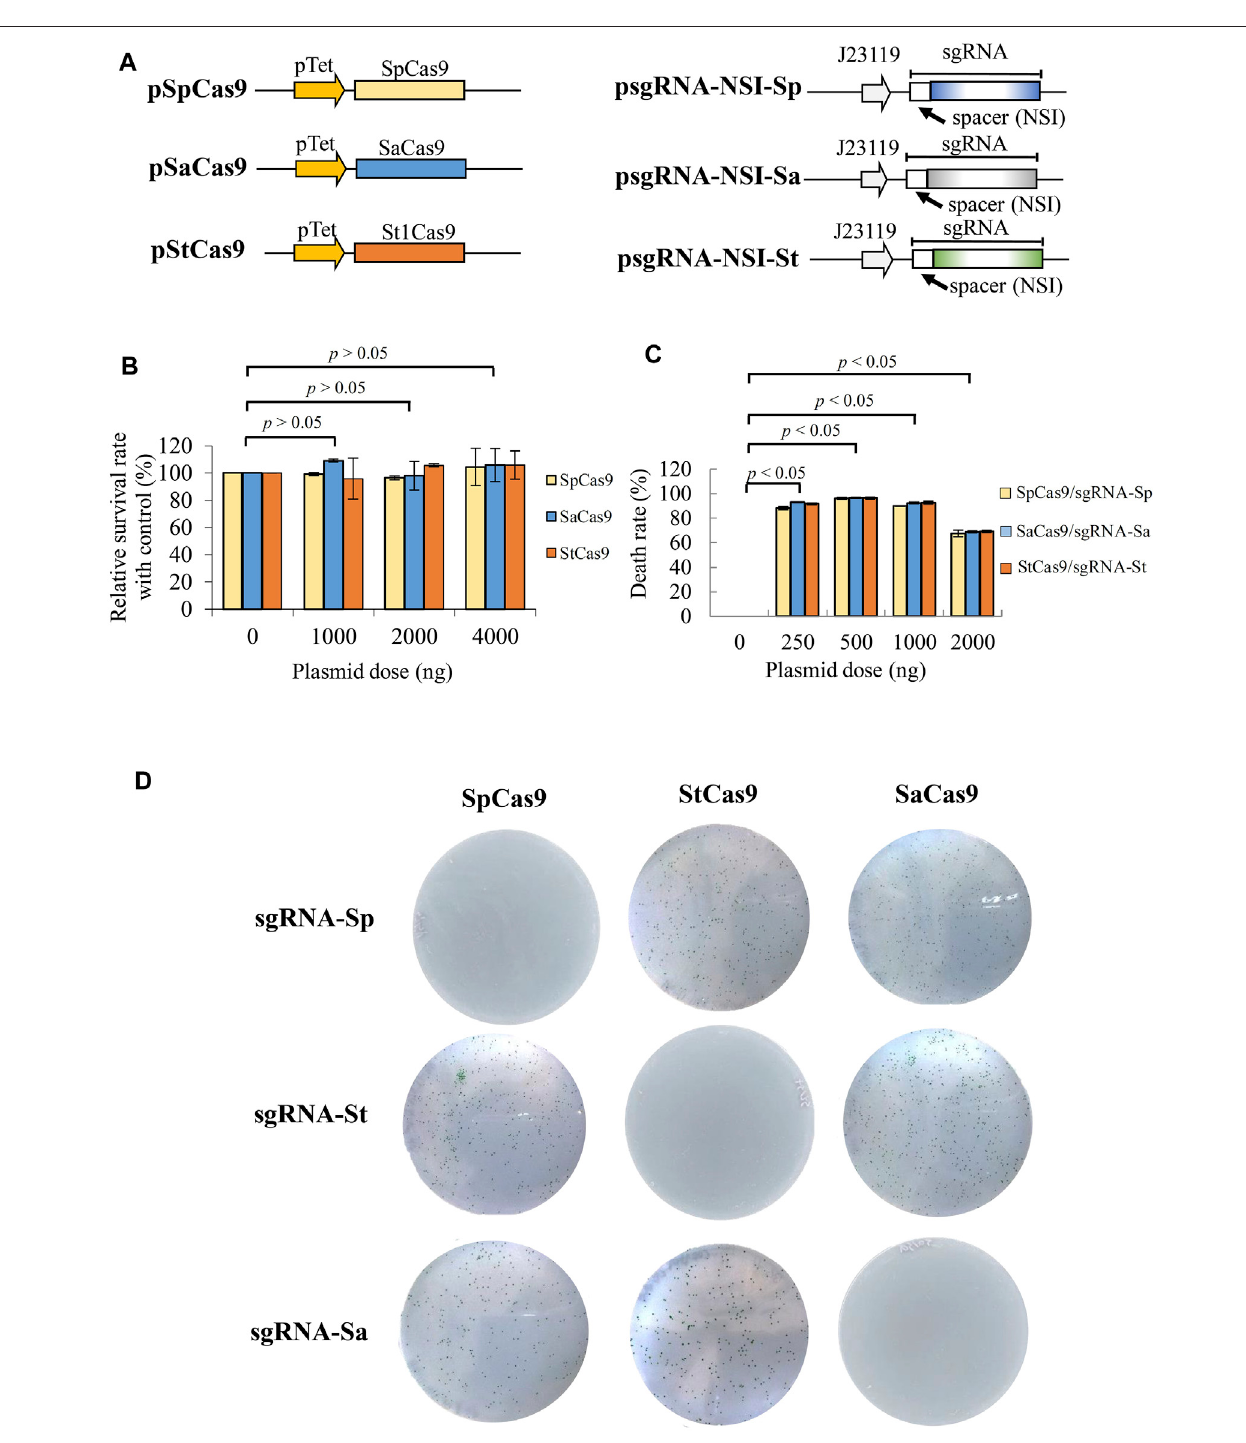
FIGURE 1 | Validation of orthogonal CRISPR systems for gene editing in PCC7942. (A) Plasmids encoding SpCas9, SaCas9, and St1Cas9 as well as plasmids encoding their corresponding sgRNA. Each sgRNA comprised identical spacer targeting NSI site but different scaffold backbone. sgRNA was driven by J23119 promoter. (B) Survival rate relative to the control. Cas9-expressing plasmid was transformed alone at different doses (1,000 – 4,000 ng). Nontransformed cells (0 ng) served as the control. Survivalrate was assessed by (CFU/CFUcontrol) × 100%. (C) Death rate induced by different cognate Cas9/sgRNApairs. Cas9-expressing plasmid was co-transformed with the corresponding sgRNA-expressing plasmid at different doses, and the death rate was assessed using nontransformed cells (0 ng) asthecontrol.Thedeathratewascalculatedby(1-CFU/CFUcontrol)×100%. (D) OrthogonalitytestforthreeCas9variants.TheCas9-andsgRNA-expressingplasmids were co-transformed into PCC7942 and streaked to plates. The plates were observed at day 7 – 9. The data represent the mean ± SD of three independent culture experiments and were analyzed by one-way ANOVA. p < 0.05 was considered statistically signi fi cant.